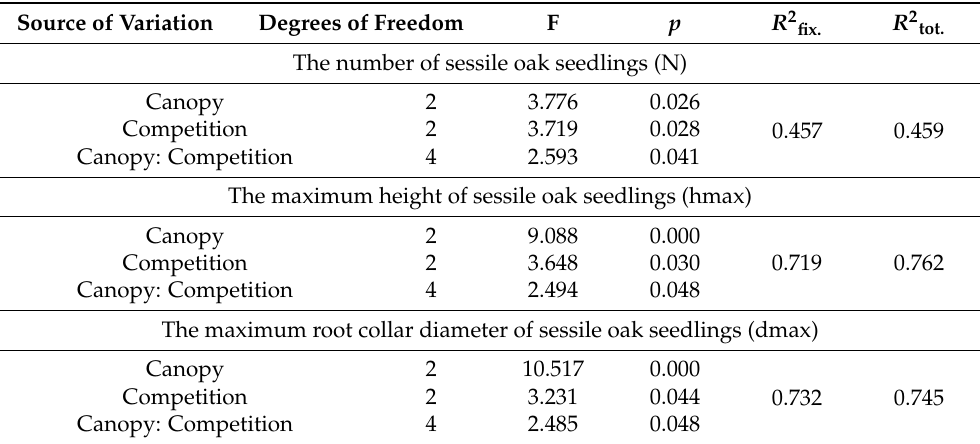
Table 2. Results of the linear mixed model for estimating the number (N), maximum height (hmax), and maximum root collar diameter (dmax) of eight-year-old sessile oak seedlings in relation to the canopy openness (silvicultural treatment) and the degree of competition (fixed factors) at different study sites (random